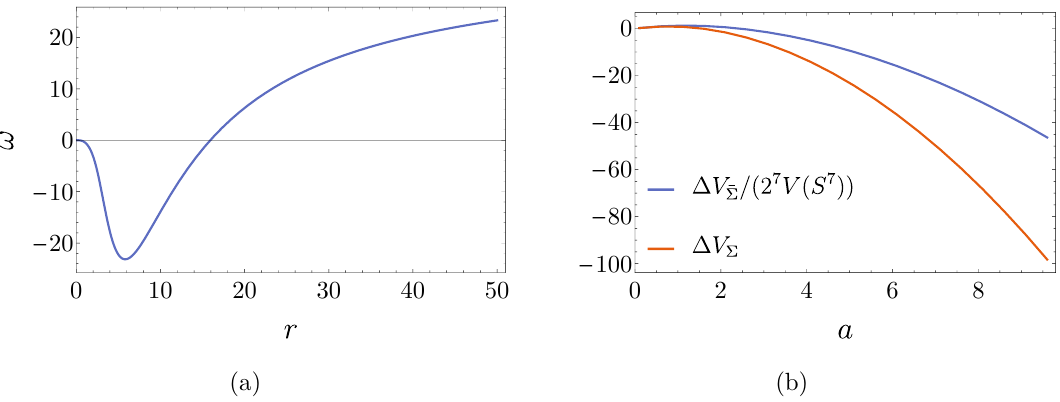
Figure 1. (a) ω ( r ) for a = 5 , and (b) the vacuum-subtracted volume as function of a in units of L .